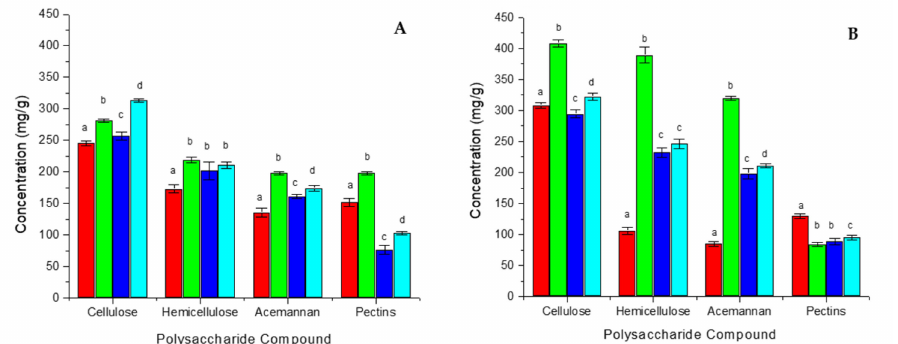
Figure 1. Polysaccharide compounds from the different Aloe vera gel samples: ILF (red), DAG60 (green), DAG80 (blue), DAG100 (cyan) ( A ). AILF (red), AAG60 (green), AAG80 (blue), AAG100 (cyan) ( B ). Error bars indicate SD. Significant differences for different samples for each compound are indicated by different letters. (The exact values can be found in Table S1 of the Supplementary